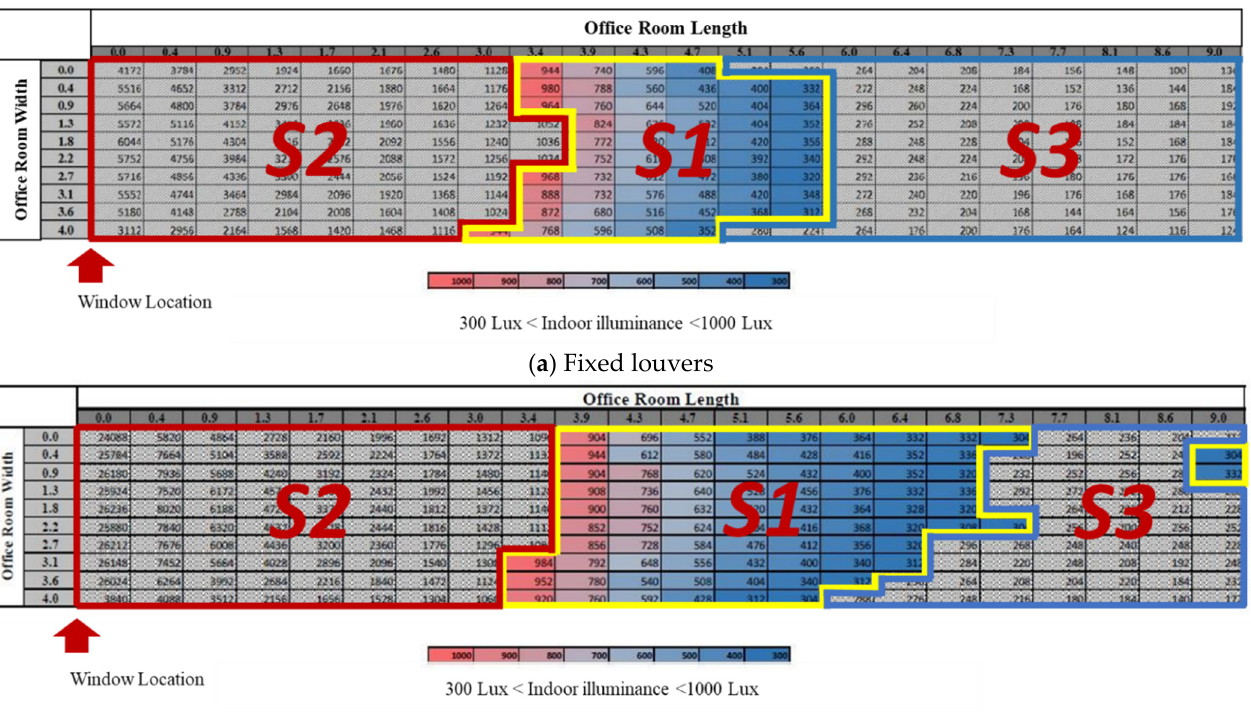
Figure 7. Indoor illuminance distribution (on the assumed horizontal grid surface considered) in the office categorized with the three ranges of indoor illuminance s 1 , s 2 , and s 3 for ( a ) fixed louvers and ( b ) responsive louvers set with the optimum angle utilized at noon on 21 June for south facade in Phoenix .